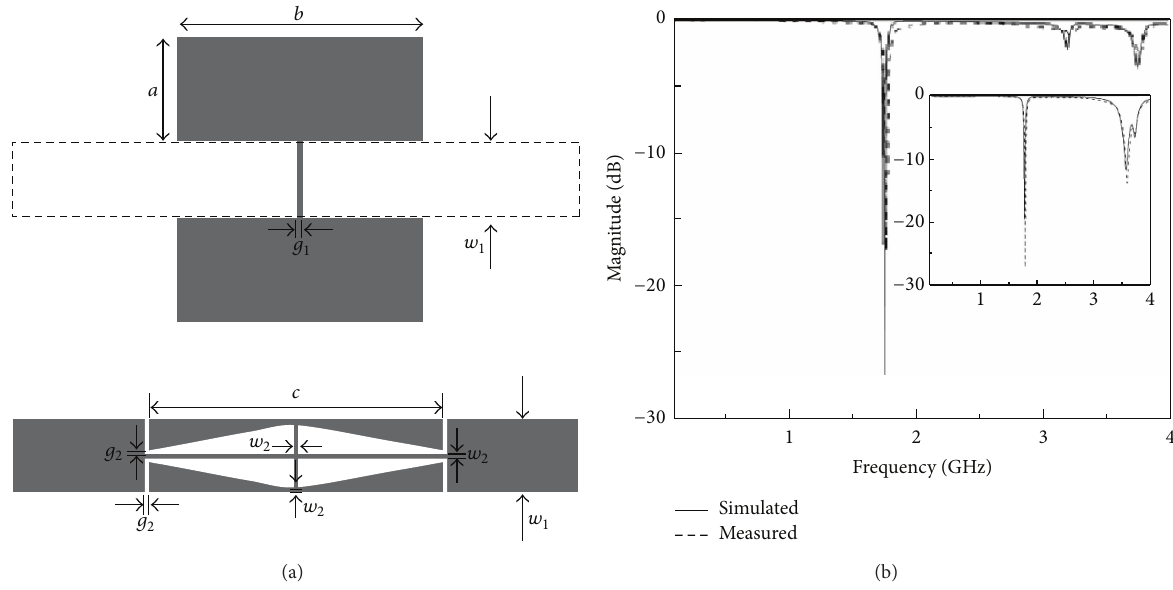
Figure 17: (a) 1-D EBG structures: top is DGS, and bottom is CMRC cell; (b) suppression of the second harmonic at 3.6 GHz.